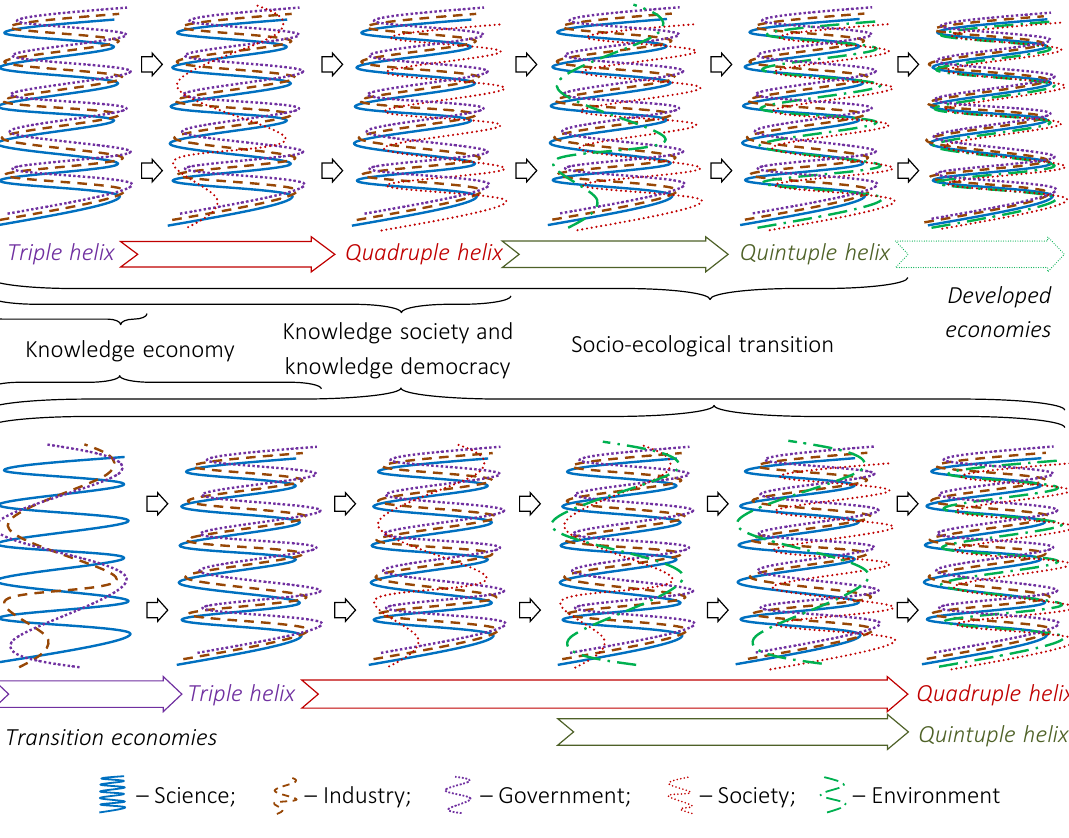
Figure 2. Quintuple helix model as a stable knowledge